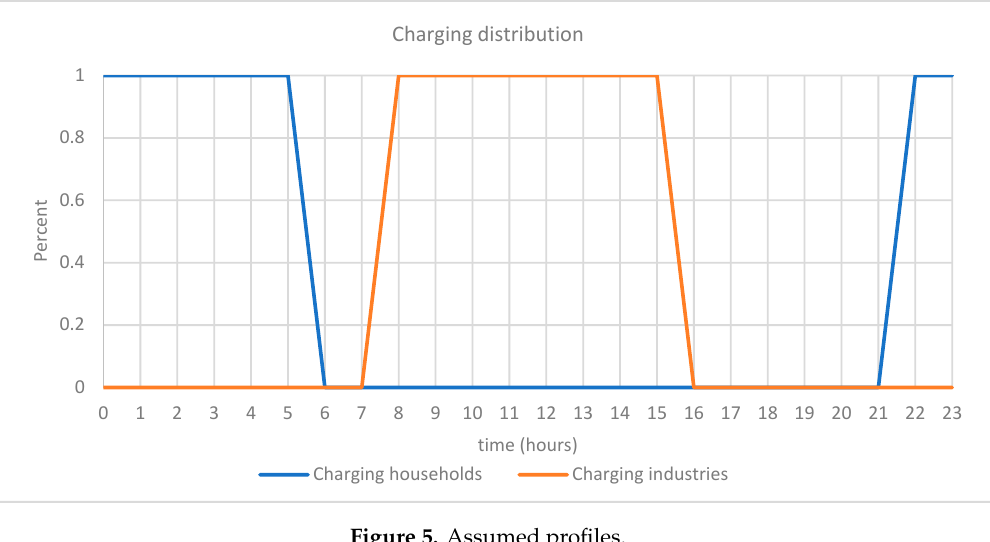
Figure 5. Assumed profiles.